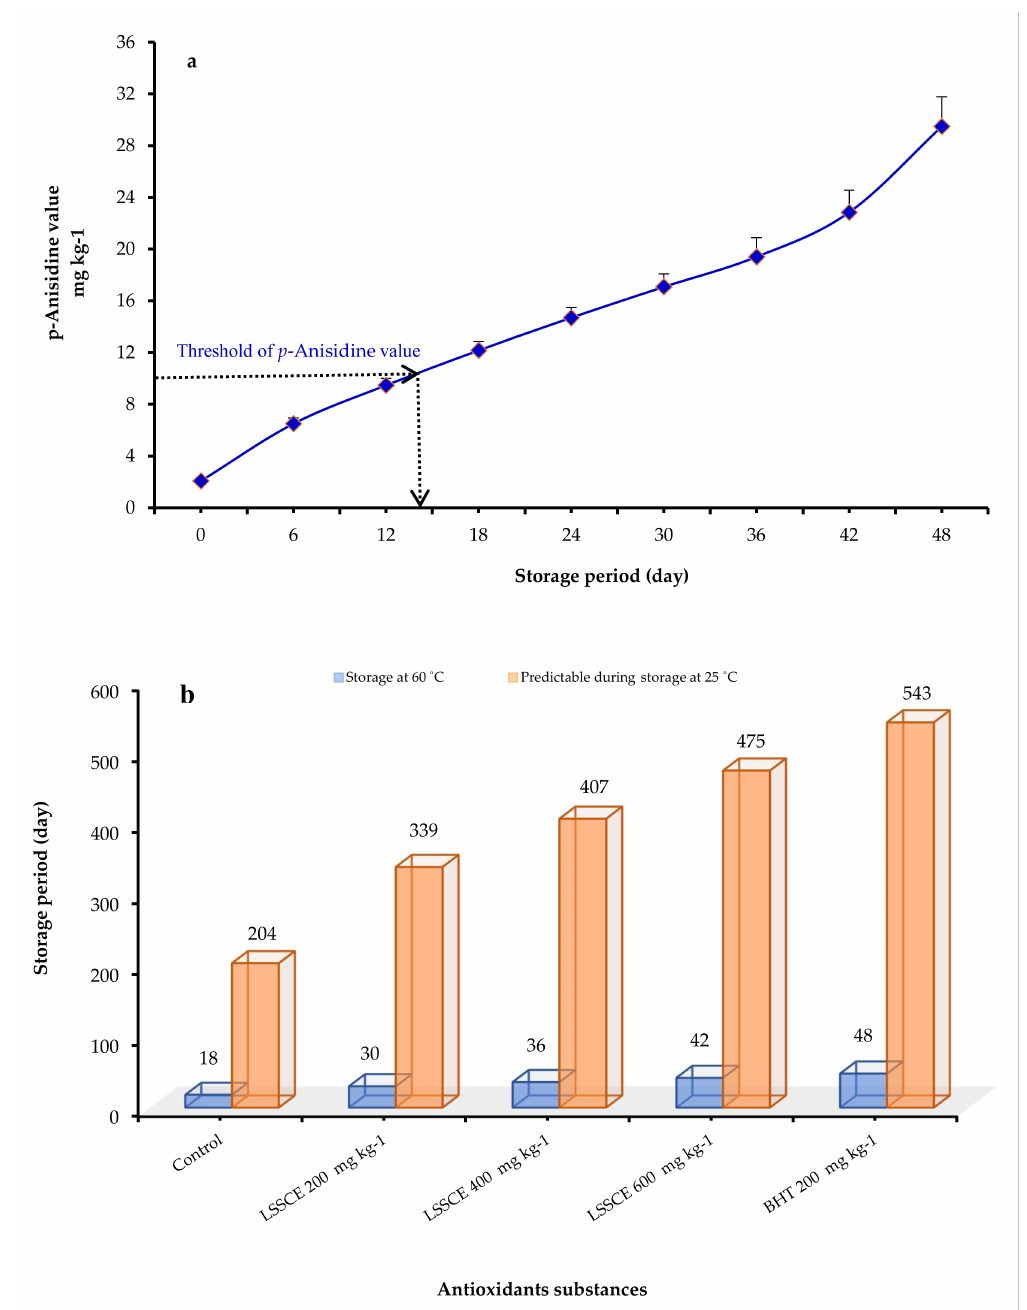
Figure 5. ( a ) Threshold of the p -anisidine value when ROO is stored at 60 ◦ C up to 48 days. ( b ) The shelf life of ROO stored at 60 ◦ C and the predicted shelf life at ambient temperature (25 ◦ C). Based on the data provided by oxidation markers, sensory evaluation, and assuming Q 10 , the shelf life of ROO samples kept at 60 ◦ C and the predicted shelf life at ambient conditions (25 ◦ C) were plotted in (Figure 5b). The data illustrated that the shelf life